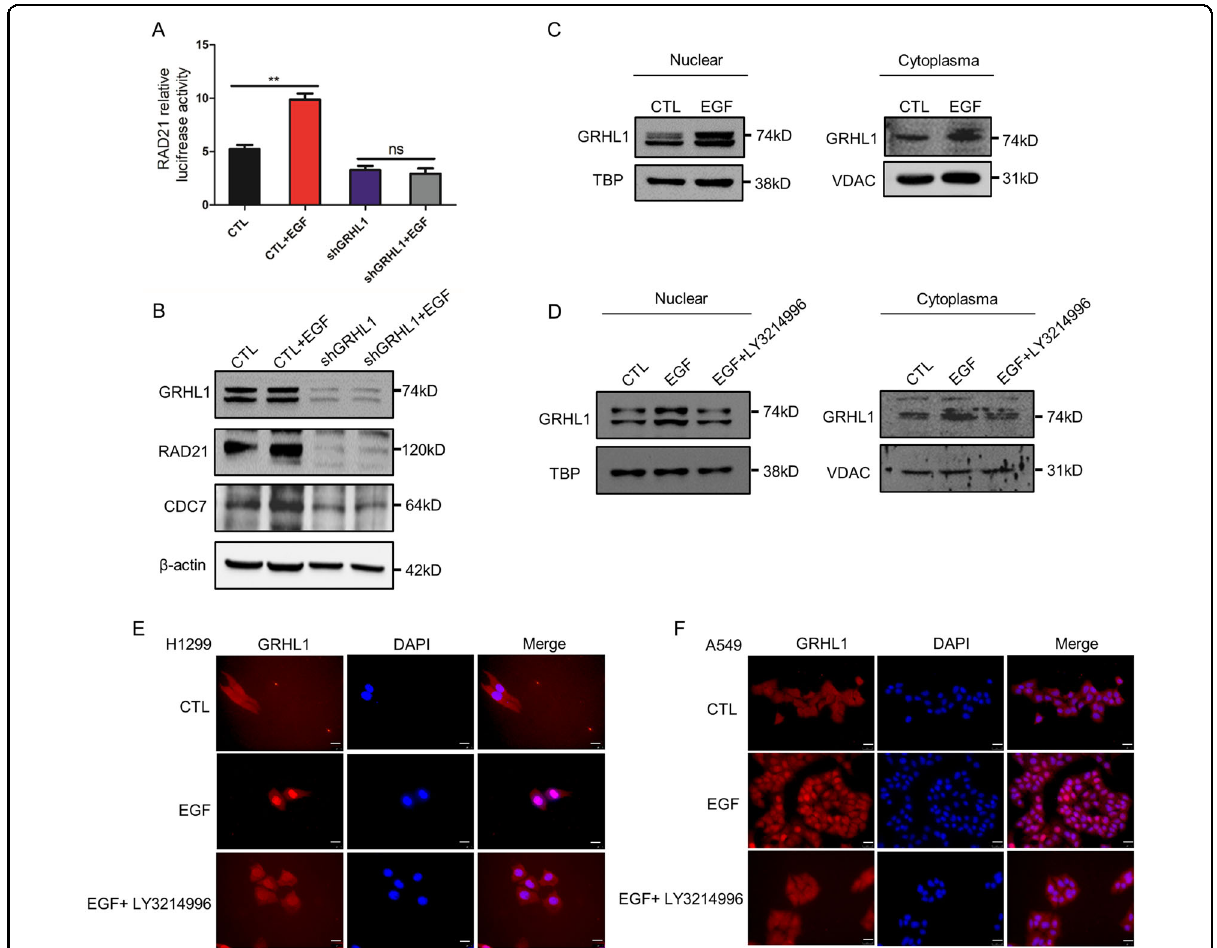
Fig. 5 EGFR-ERK pathway activates GRHL1 and promotes its nuclear translocation. A pGL3-enhancer vector containing RAD21 promoter fragment was transfected into A549-control cells and A549-shGRHL1 cells, co-transfected with Renilla control plasmid. After serum-free treatment for 12 h, EGF (100 ng/ml) was added to two groups to stimulate for 24 h. The relative levels of luciferase activity were normalized to the levels of luciferase activity of the Renilla control plasmid. Data represent the average of three independent experiments (mean ± SD). ** P < 0.01. B After serum-free treatment for 12 h of A549-control cells and A549-shGRHL1 cells, EGF (100 ng/ml) was added to two experimental groups. Twenty-four hours later, the cells were lysed. Protein expression was assessed by western blotting using the indicated antibodies. C After 24 h of stimulation with EGF (100 ng/ml), the nuclear and cytoplasmic fractions were separated and the location of GRHL1 was detected by western blot in A549 cells. TBP: TATA binding protein, VDAC: mitochondrial outer membrane protein porin. D After serum-free treatment for 12 h of A549 cells, LY3214996 (ERK inhibitor, 300 nM) was added. 12 h later, EGF (100 ng/ml) was added to both two experimental groups. After 24 h, the nuclear and cytoplasmic fractions were separated and the location of GRHL1 was detected by western blot. E, F After serum-free treatment for 12 h of A549 and H1299 cells, LY3214996 (ERK inhibitor, 300 nM) was added. 12 h later, EGF (100ng/ml) was added to both two experimental groups. After 24 h. The location of GRHL1 was detected by immuno fl uorescence staining. Cells were stained with anti-GRHL1 (left panel, red) and DAPI (middle panel, blue). The merged images are shown in the right panel. Scale bar = 25 μm, magni fi cation: